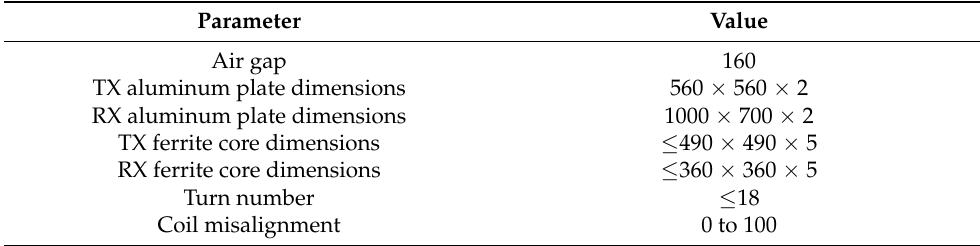
Table 3. Predetermined geometric parameters and constraints of the coil assembly pair. The unit of all parameters is mm.